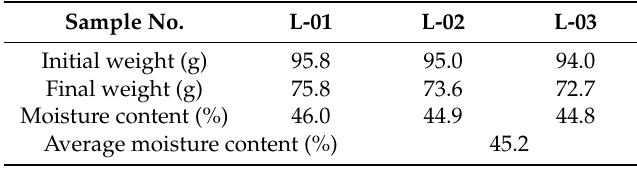
Table 3. Low moisture content samples.